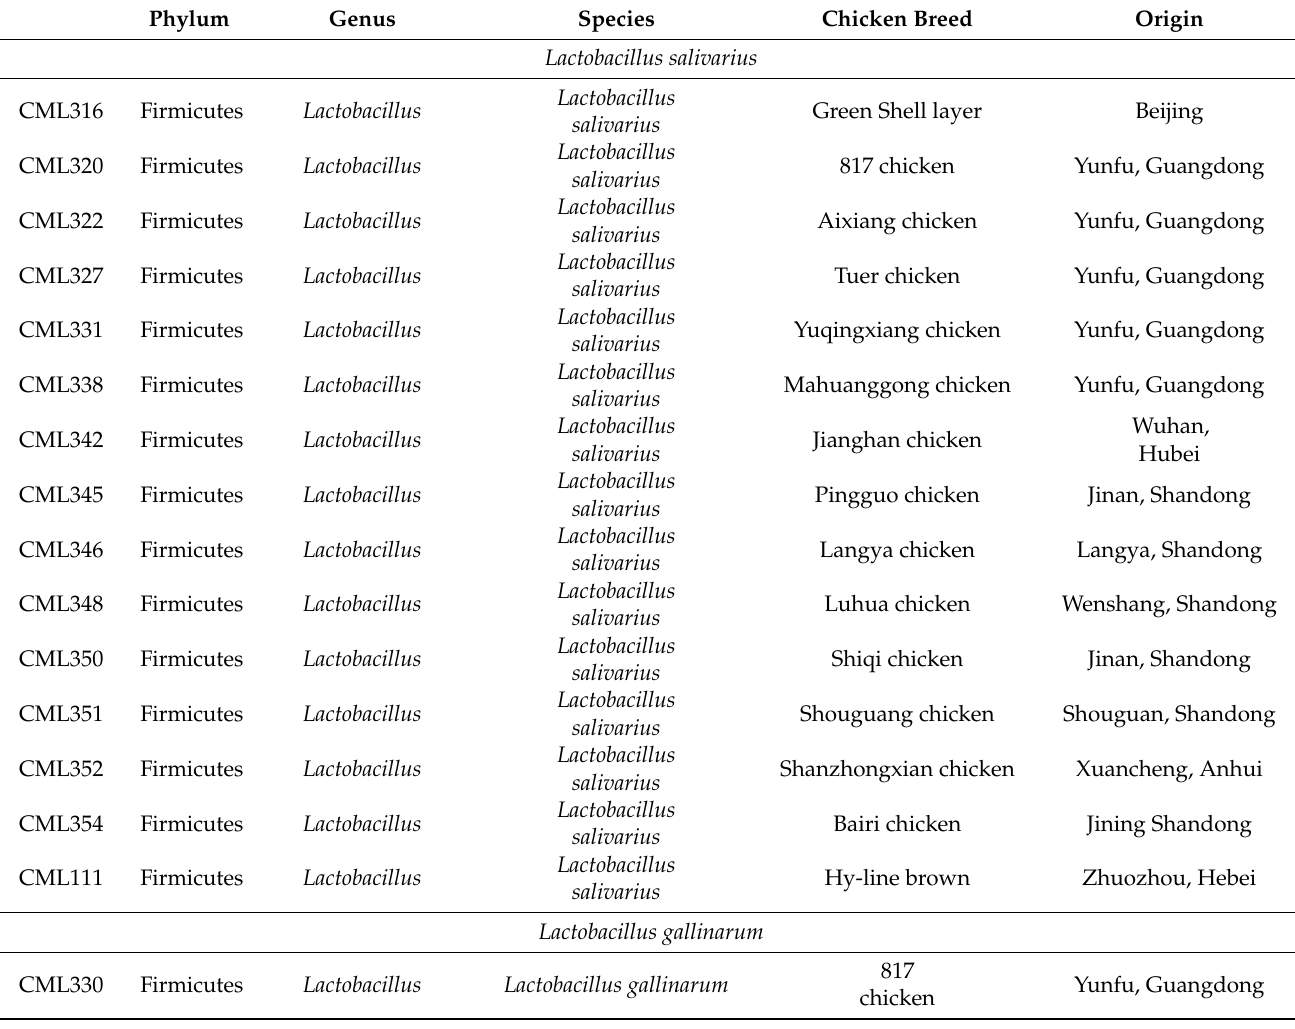
Table 3. Information of 57 LAB isolates from the chicken